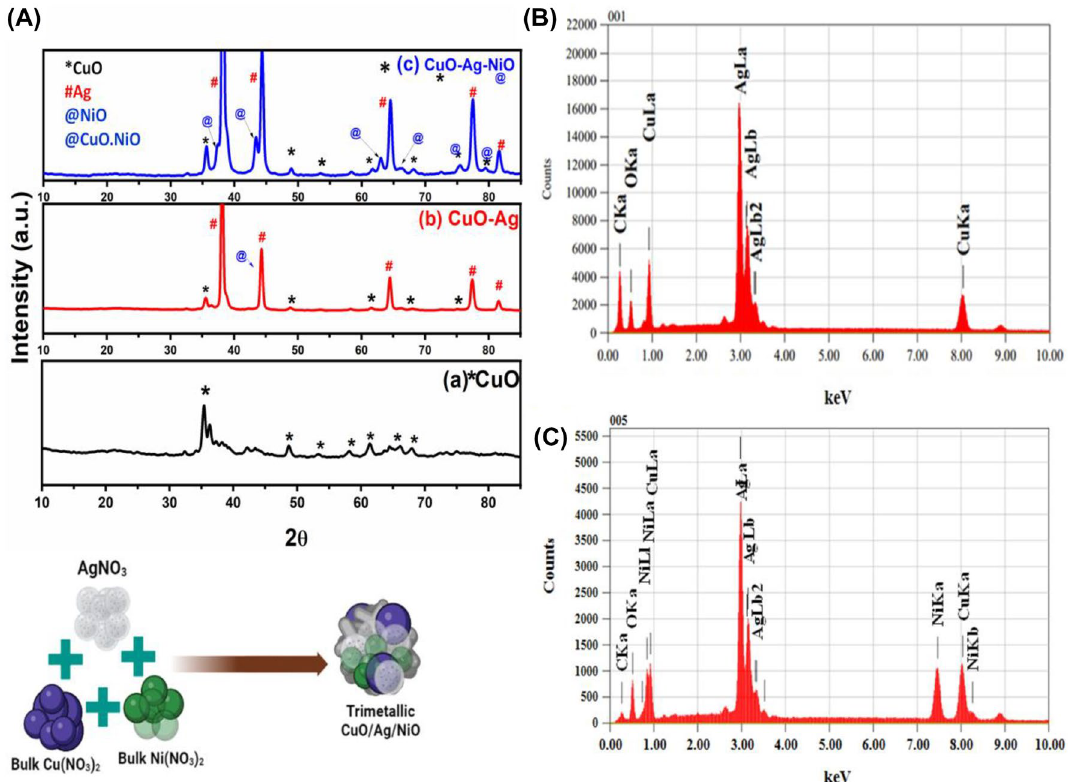
Figure 1. P–XRD result of ( A ) (a) CuO, (b) CuO/Ag, (c) CuO/Ag/NiO; EDX results of ( B ) CuO/Ag, and ( C )